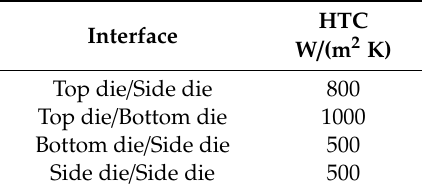
Table 4. HTCs at the die / die